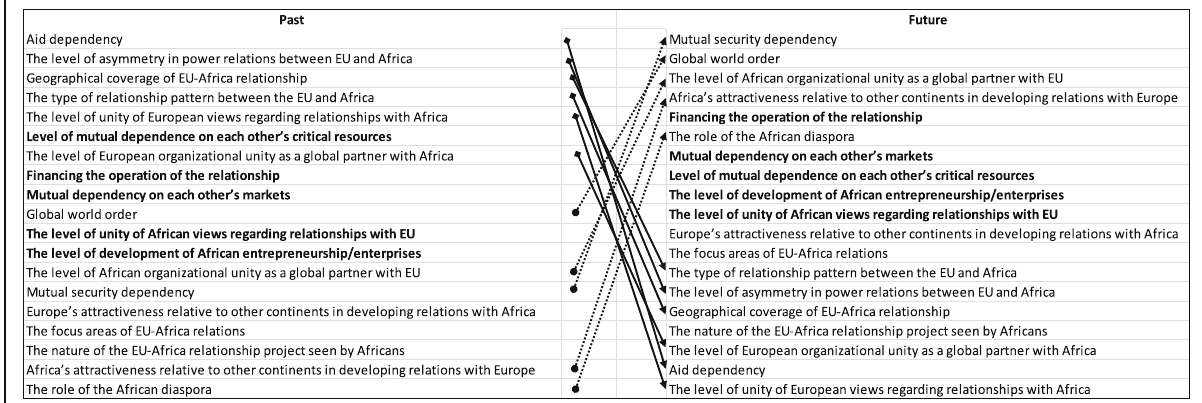
Fig. 2 Evolution of the influence of the identified factors from past to future. Source: